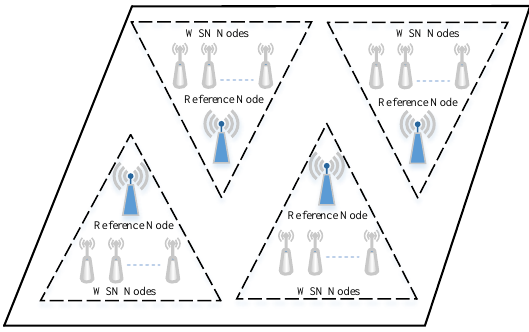
Figure 4. The architecture of time synchronization among different